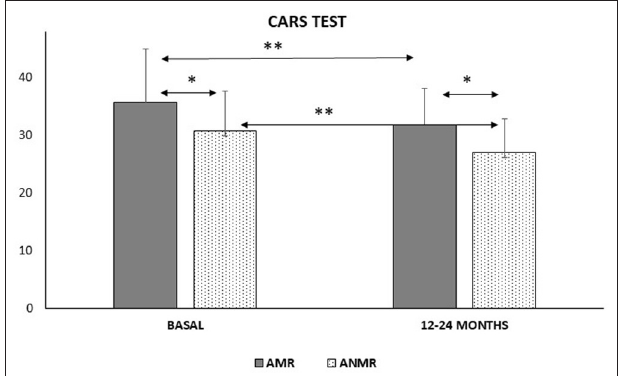
FIGURE 1 | Comparison of the Childhood Autism Rating Scale Test (CARS-2) scores between the neurodevelopmental regression (AMR) and non-neurodevelopmental regression (ANMR) groups in two study times of follow-up declined similarly for both groups. * p < 0.05, ** p < 0.01.